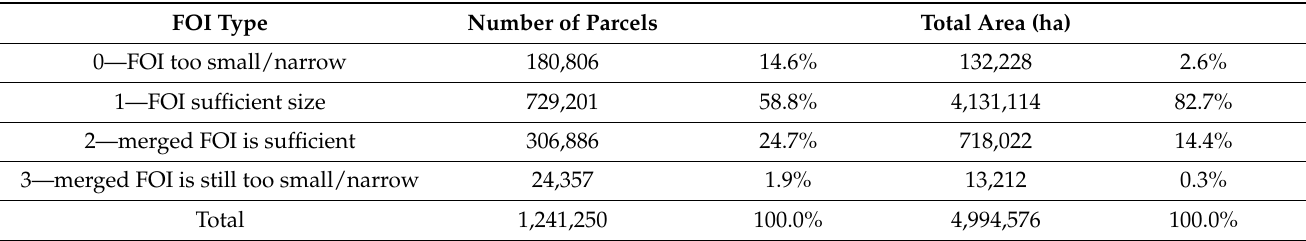
Table 2. Count and area of parcels sufficiently large and too small or narrow for Sentinel-2-based analysis, including the results of FOI